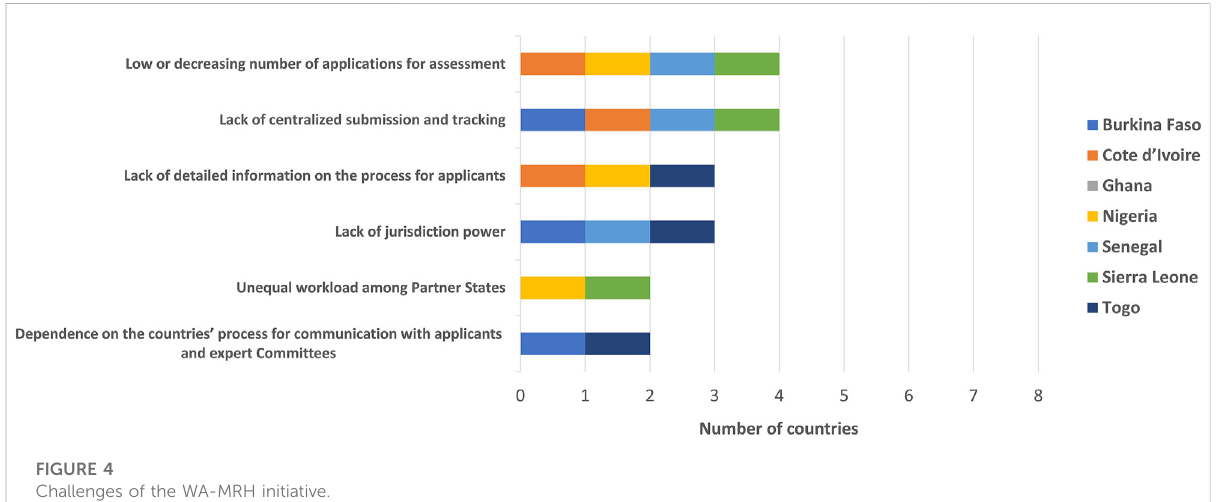
FIGURE 4 Challenges of the WA-MRH